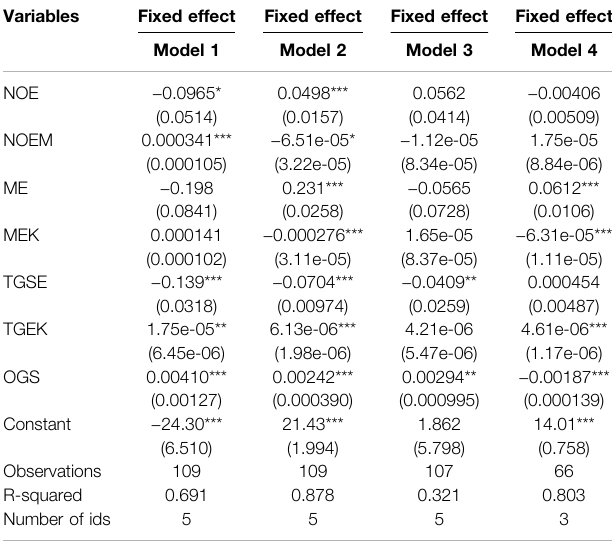
TABLE 4 | Climate extreme and agriculture dynamics under fi xed effect